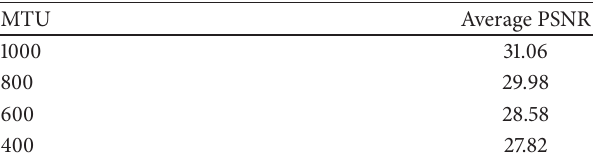
Table 1: The average PSNR value of simulation results. Table 2: The simulation results of the average PSNR